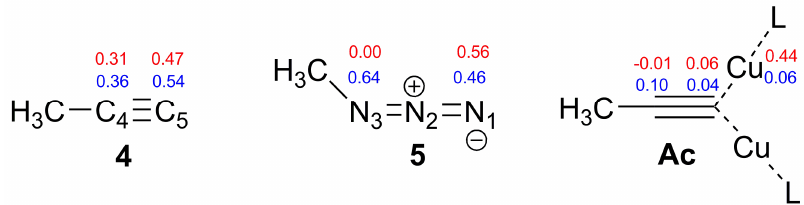
Figure 2. Electrophilic P k+ (red) and nucleophilic P k- (blue) Parr functions at 4 , 5 and Ac (L = abt).